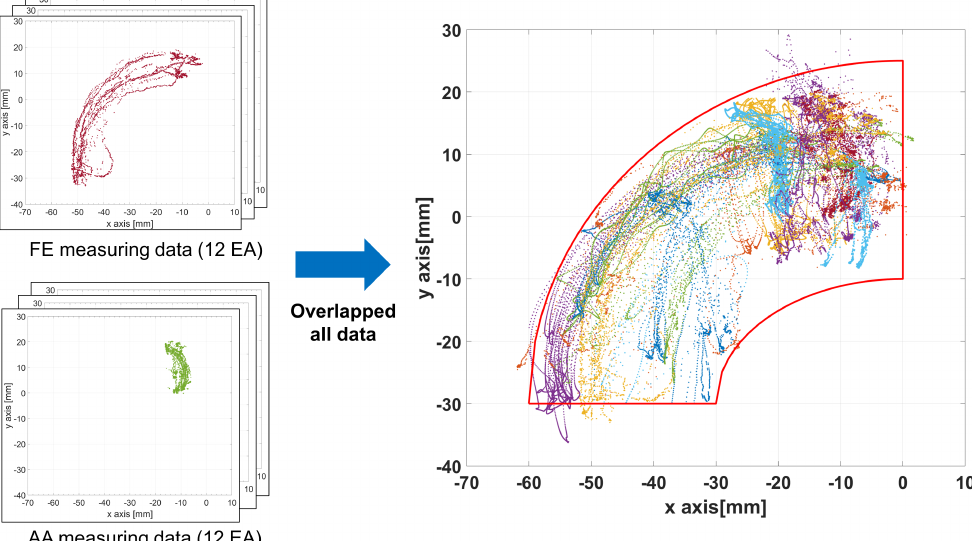
Figure 8. Target workspace defined by the measured trajectories of the thumb through motion capture